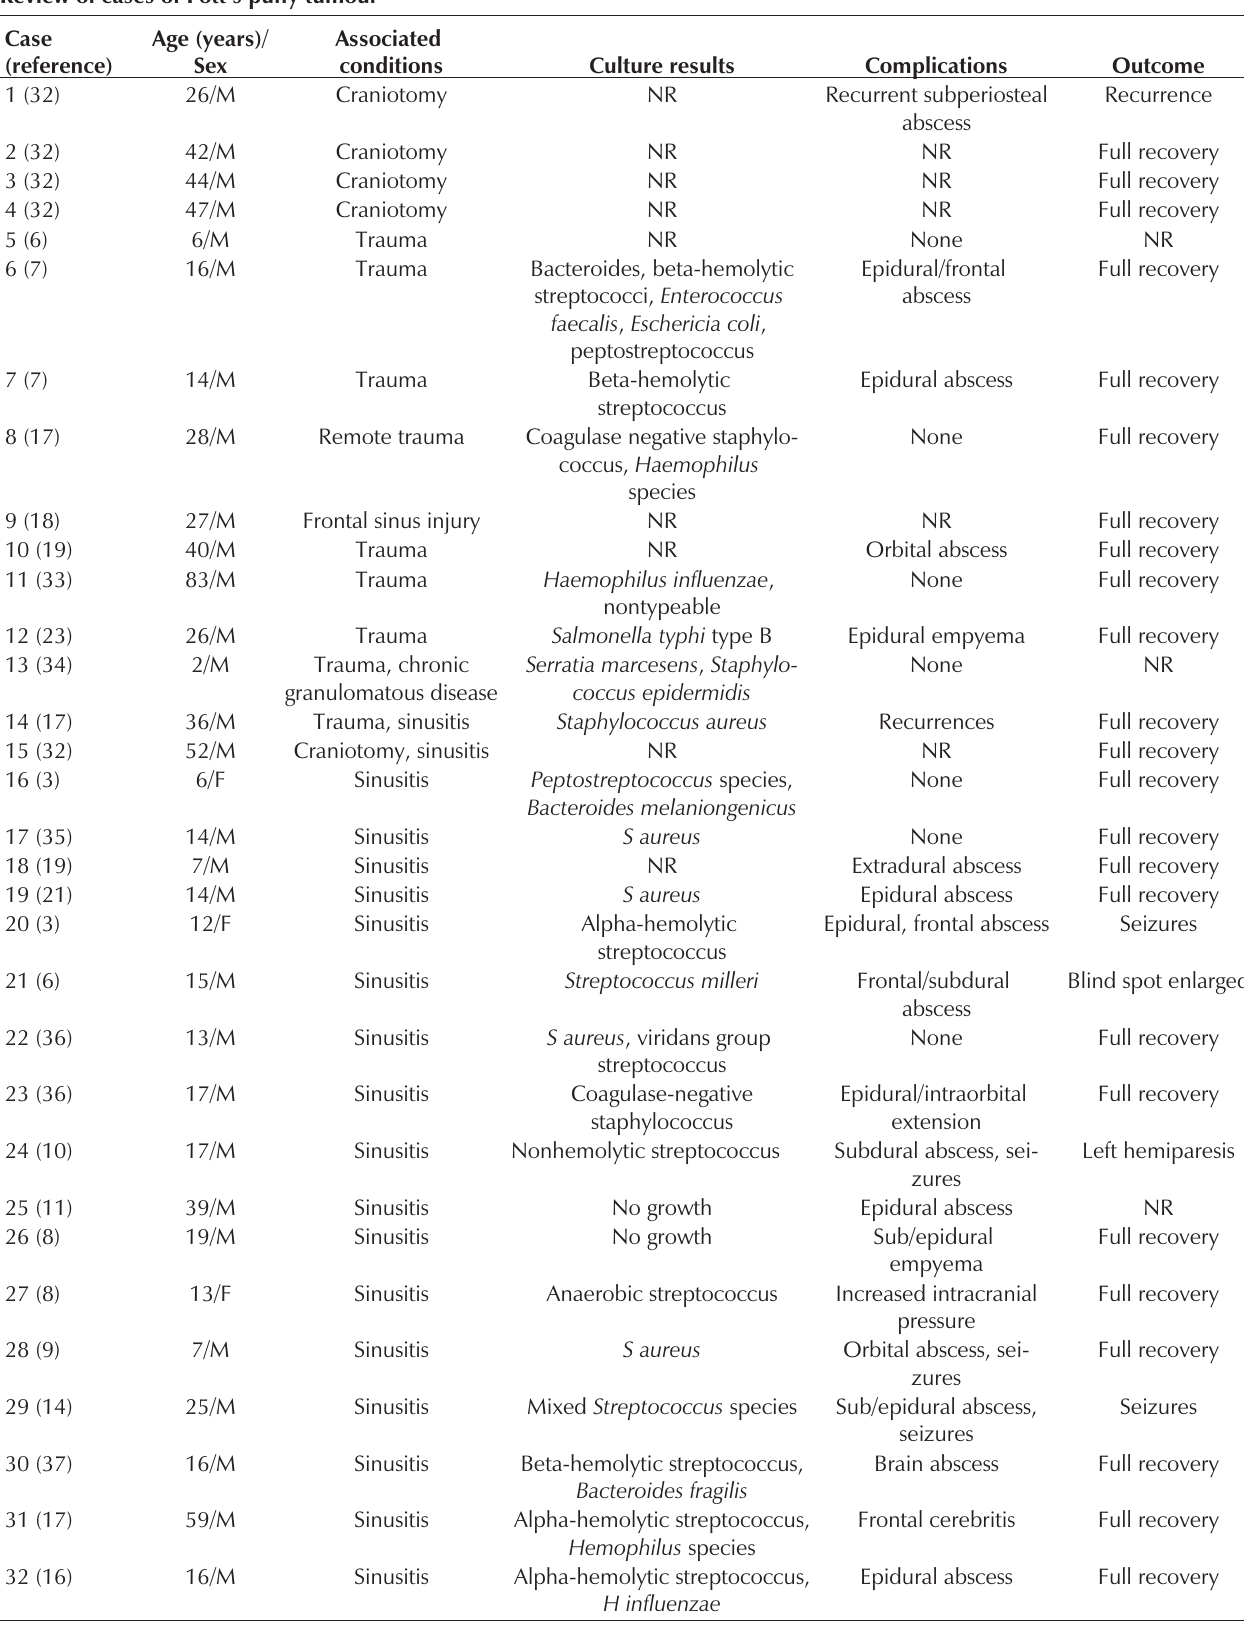
Review of cases of Pott’s puffy